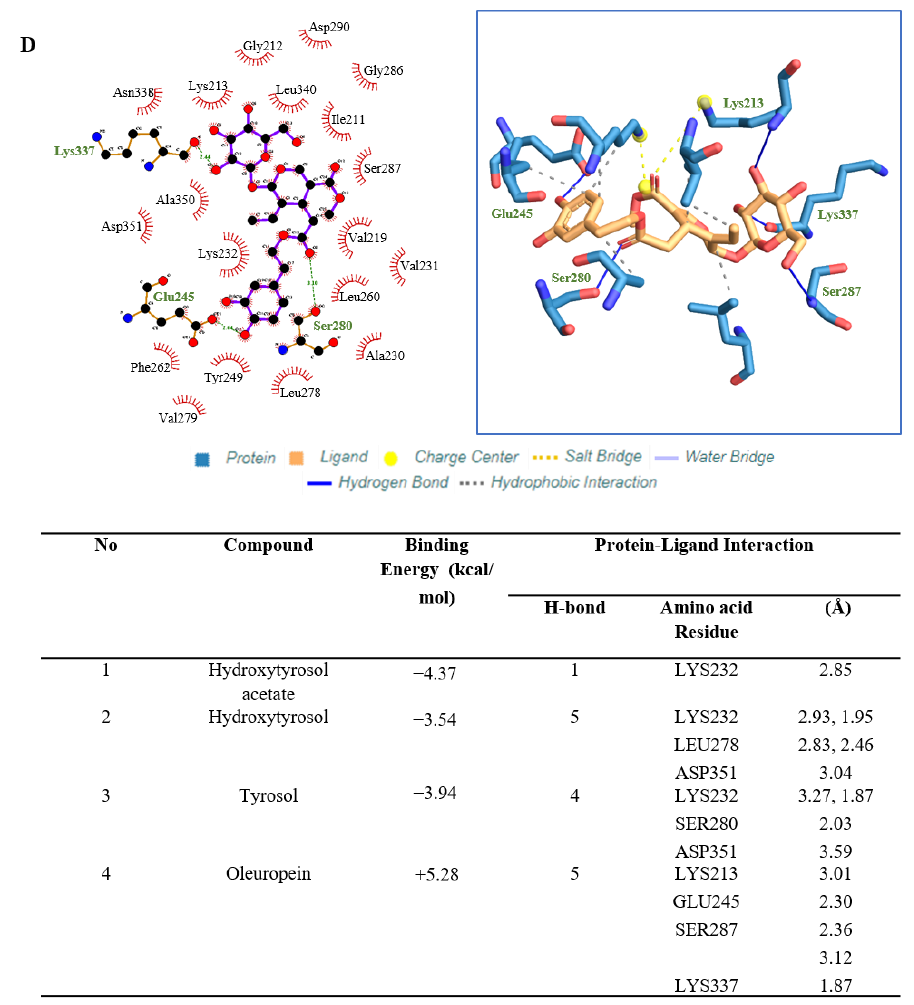
Figure 7. Molecular docking studies show ligand binding in the active pockets of ALK5 receptors. ( A ) HT acetate. ( B ) HT. and ( C ) Tyrosol. ( D ) Oleuropein. The dark blue line indicates the hydrogen bond, the dashed line indicates the hydrophobic interaction.